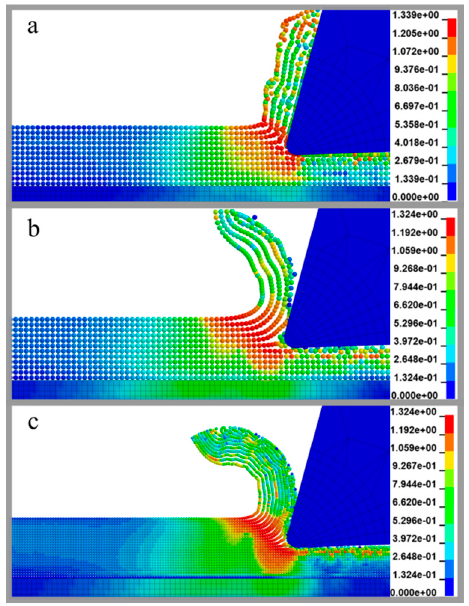
Figure 3. Equivalent stress σ eq contours in GPa for 0.04 mm depth of cut: ( a ) standard formulation and d = 0.01 mm; ( b ) renormalized formulation and d=0.01 mm; ( c ) renormalized formulation and d = 0.005 mm.